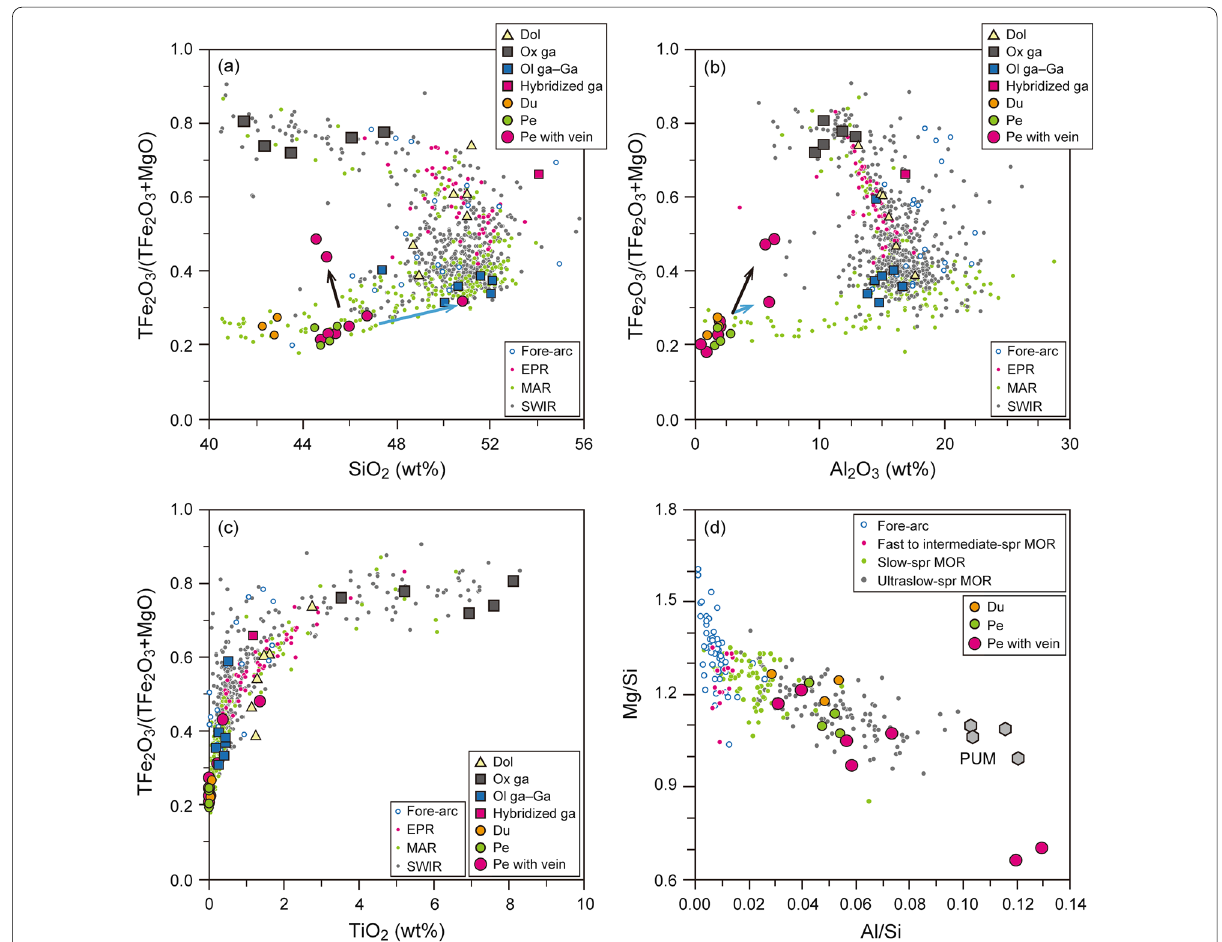
Fig. 5 Bulk major‑element compositions (in wt%). The black and blue arrows represent reaction trends between oxide gabbroic melt–peridotite, and gabbroic melt–peridotite, respectively. The background data represent bulk compositions of dolerite, oxide gabbro, gabbro, olivine gabbro, and troctolite from fore‑arc region (Mortimer et al. 1998; Meffre et al. 2012; Falloon et al. 2014; Johnson et al. 2014), fast‑spreading East Pacific Rise (EPR) (Pedersen et al. 1996; Natland and Dick 2009), slow‑spreading Mid‑Atlantic Ridge (MAR) (Godard et al. 2009), and ultraslow‑spreading Southwest Indian Ridge (SWIR) (PetDB database: Lehnert et al. 2000). Compositional data of peridotites are from fore‑arc region (Parkinson and Pearce 1998; Pearce et al. 2000; Birner et al. 2017), fast‑ to intermediate‑spreading MOR (Niu and Hékinian 1997; Regelous et al. 2016; Niu 2004), slow‑spreading MOR (Niu 2004; Regelous et al. 2016), and ultraslow‑spreading MOR (Niu 2004; Regelous et al. 2016). Primitive upper mantle (PUM) data are from Jagoutz et al. (1979), Palme and Nickel (1985), Hart and Zindler (1986), and McDonough and Sun (1995). Abbreviations: Dol dolerite, Du dunite, = = Ga gabbro, Ol ga olivine gabbro, Ox ga oxide gabbro, and Pe = = = =